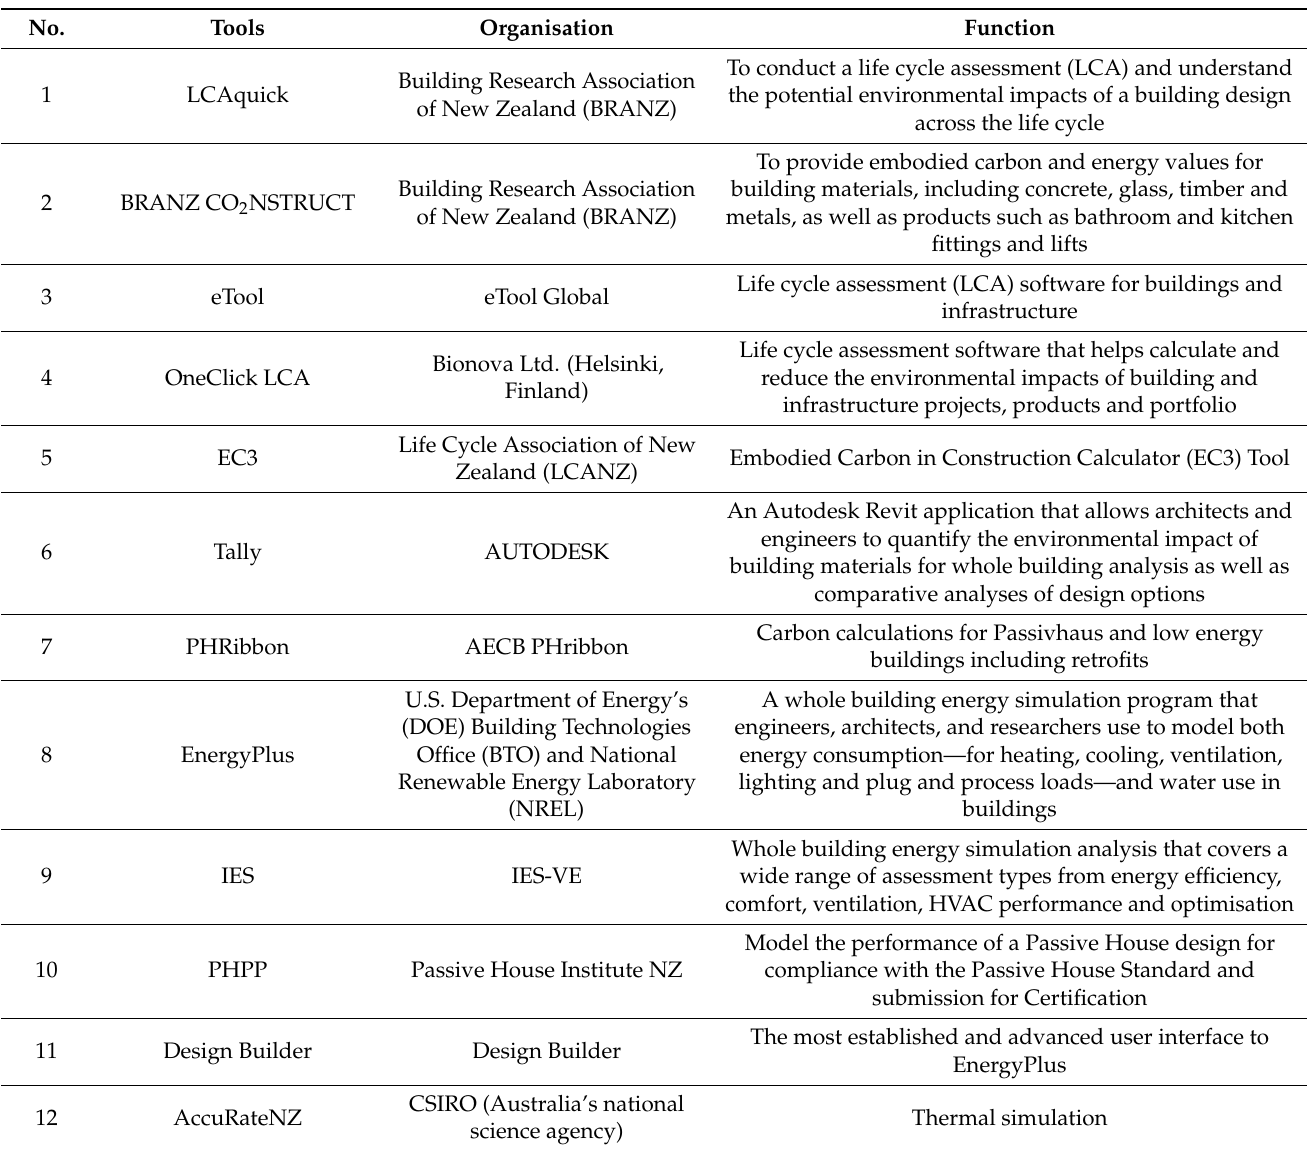
Table 4. Summary of LCA and energy modelling tools used within the New Zealand construction industry.